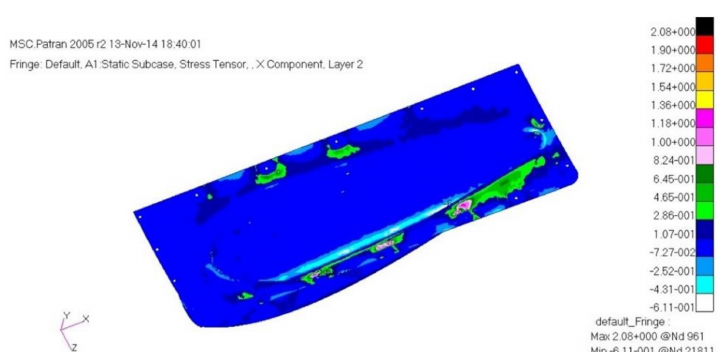
Figure 14. Stress analysis result: layer